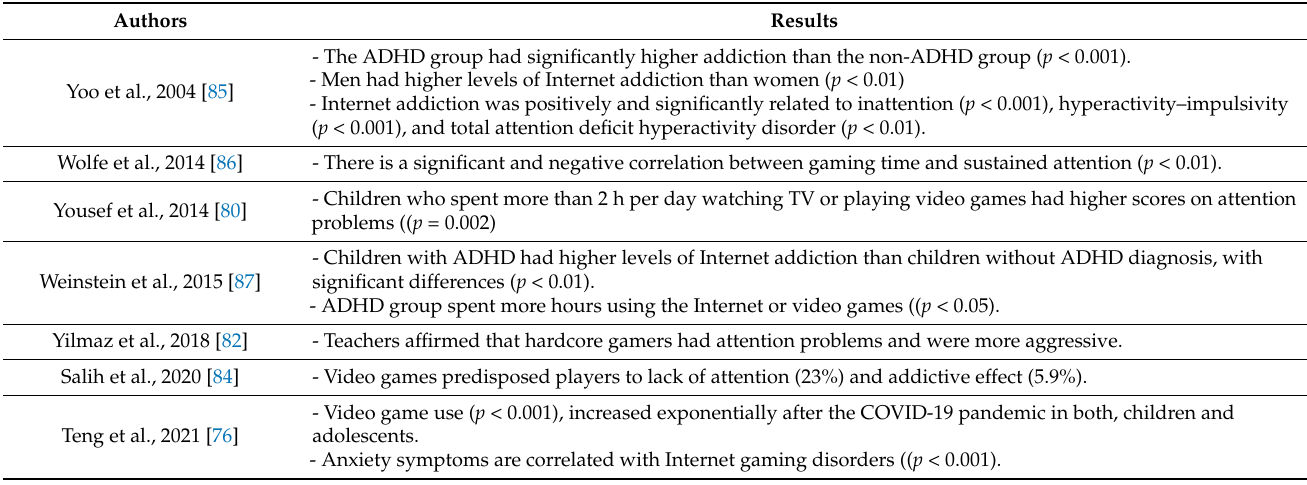
Table 2. Results related to technology addiction